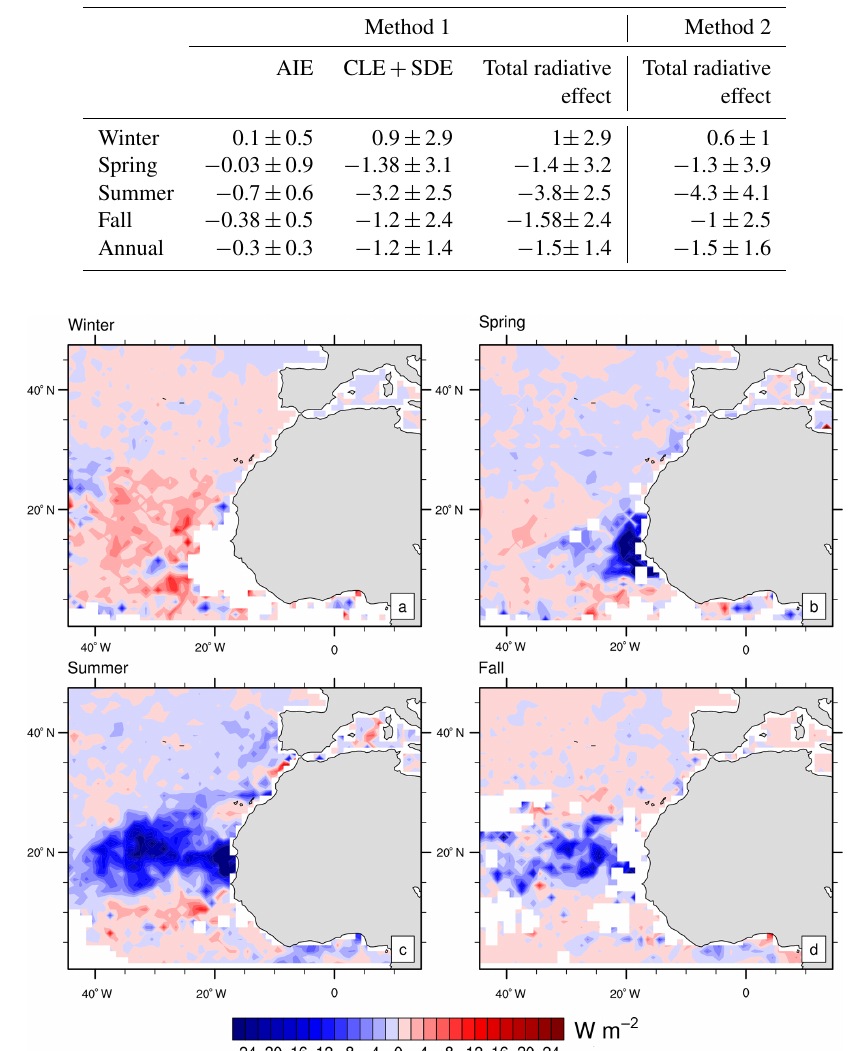
Table 1. Seasonal and annual radiative effects estimated by Method 1 (Quaas et al., 2008) and Method 2 (Chen et al., 2014).